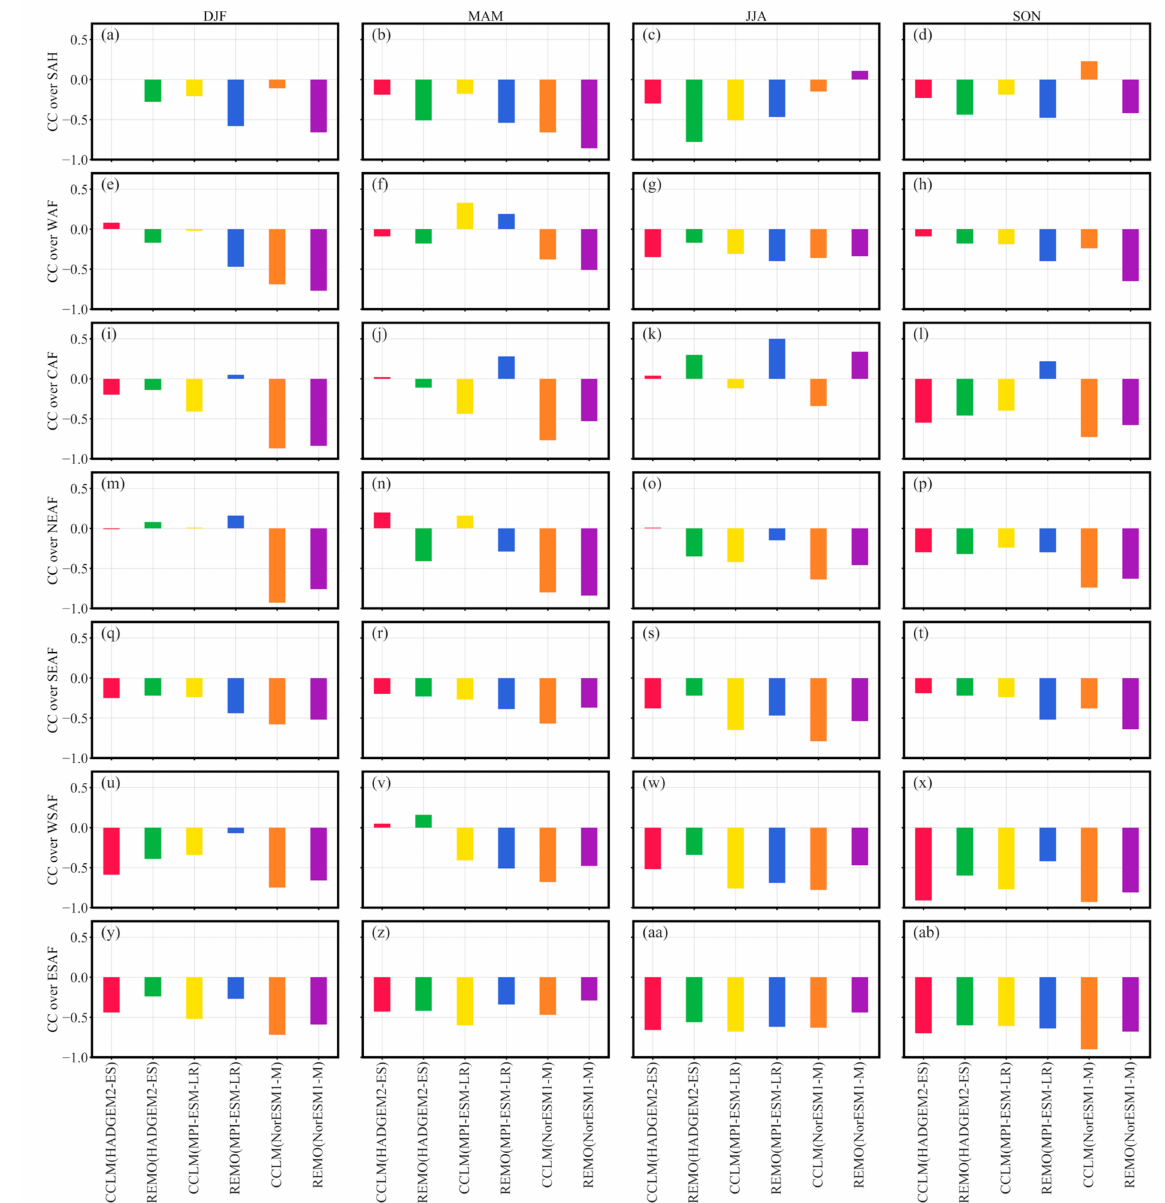
Figure 10. Correlation coefficient between the GCM/GPCC biases and the RCM increments over the regions indicated in Figure 1: ( a – d ) Sahara (SAH) region, ( e – h ) West Africa (WAF) region, ( i – l ) Central Africa (CAF) region, ( m – p ) Northern East Africa (NEAF), ( q – t ) Southern East Africa (SEAF), ( u – x ) Western South Africa, ( y – ab ) Eastern South Africa